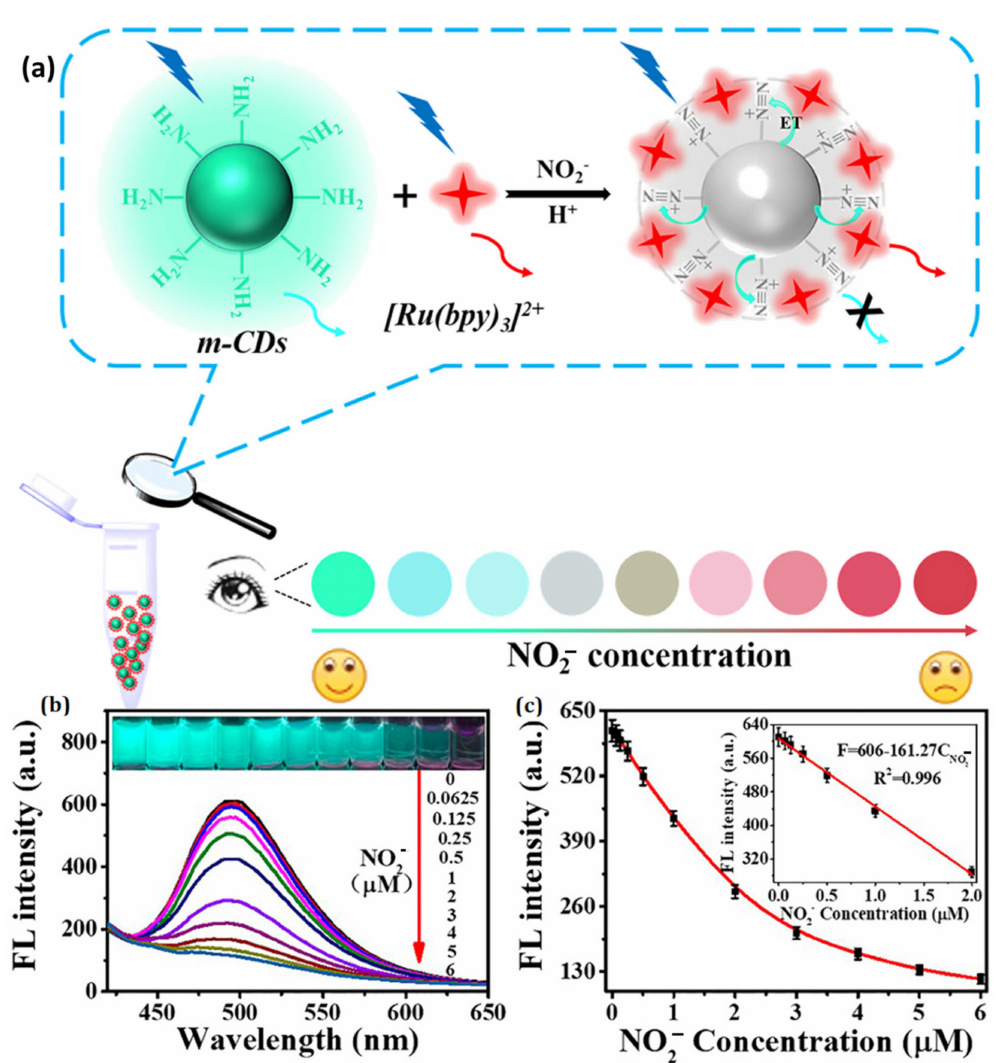
Figure 11. ( a ) Visual NO 2– detection with m-CDs@ [Ru(bpy) 3 ] Ratiometric probe. ( b ) Fluorescence spectra of m-CDs after adding NO 2– ( c ) m-CD fluorescence vs. NO 2– concentration. Reproduced with permission from ref. [124] © 2023 American Chemical